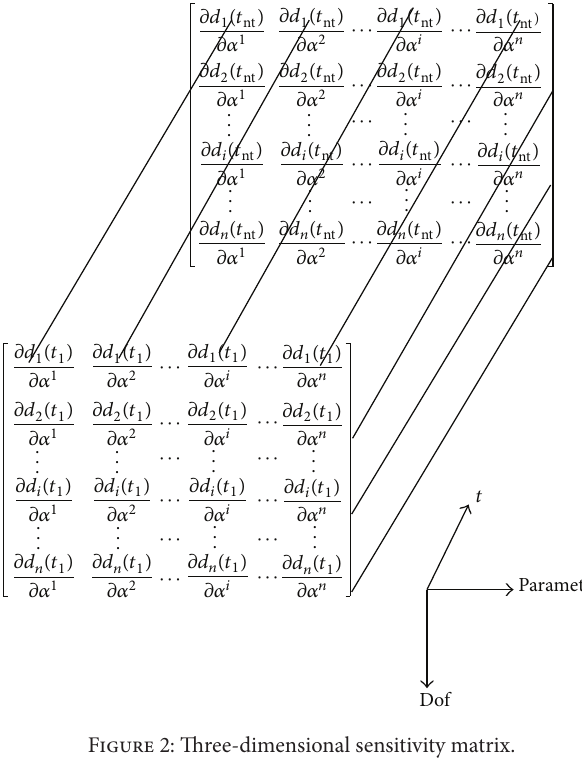
Figure 2: Three-dimensional sensitivity